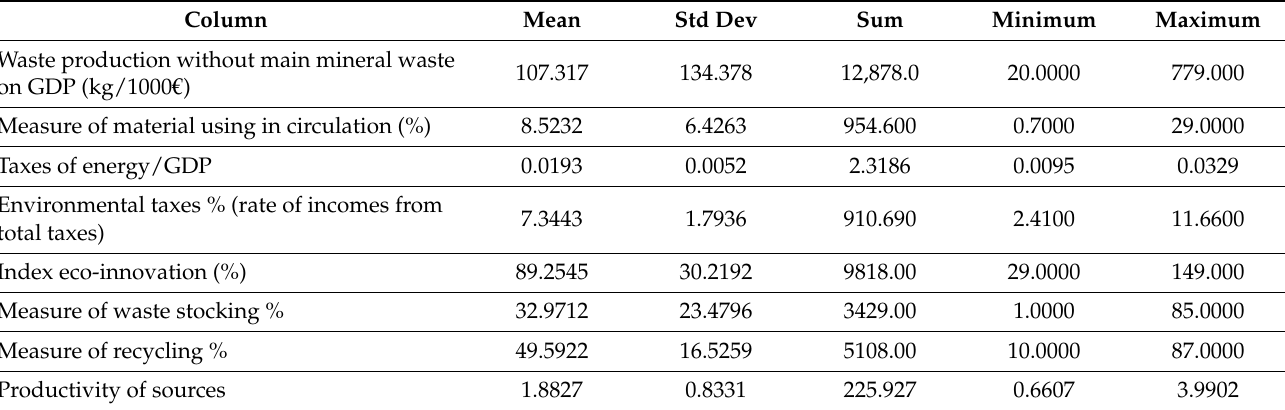
Table 2. Descriptive statistics (Univariate simple statistics) of the analyzed